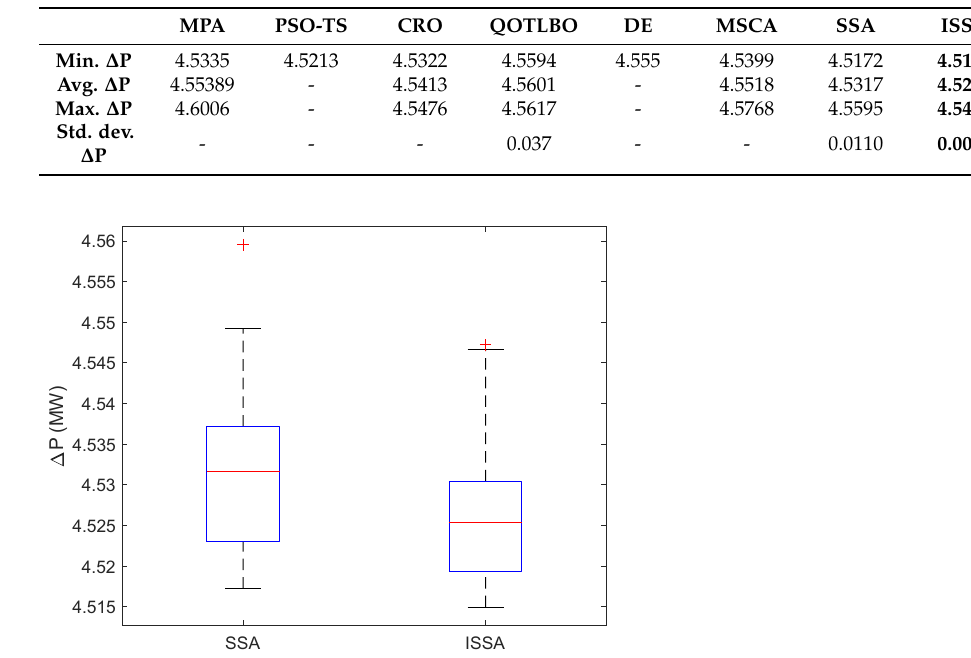
Table 10. Statistical comparison of results for power loss minimization for IEEE 30-bus system.